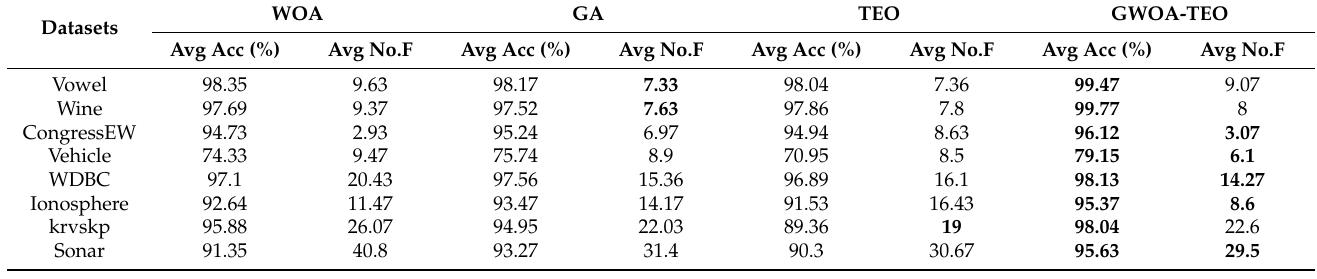
Table 6. Comparison between GWOA-TEO and the other algorithms.